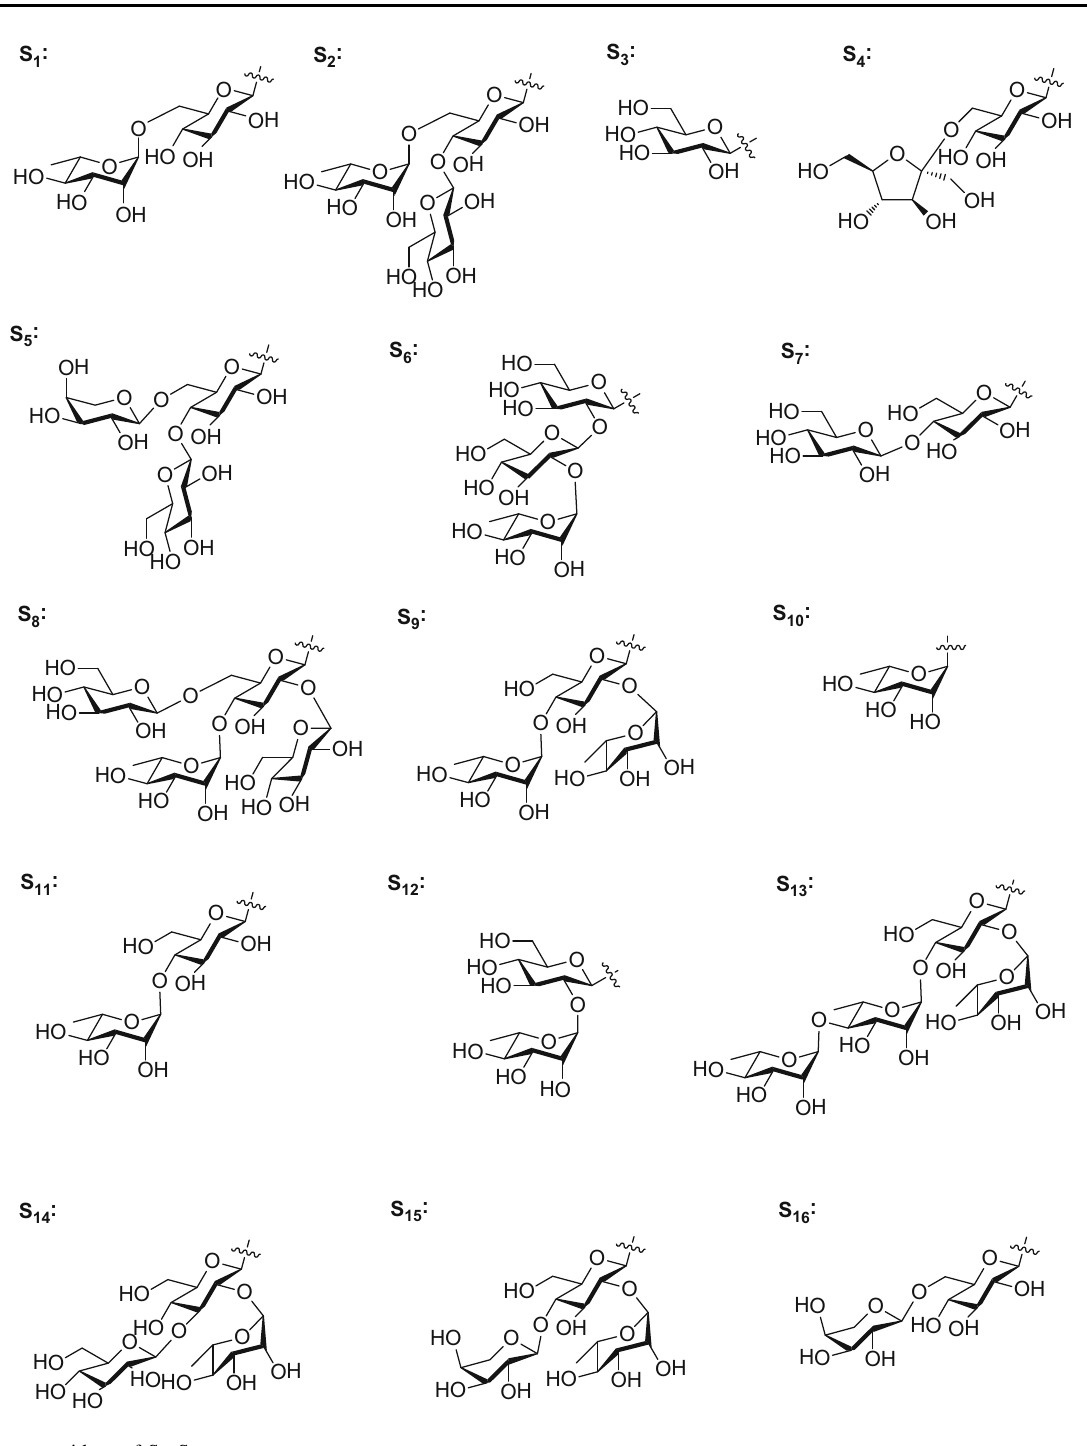
Fig. 6 Sugar residues of S 1 –S